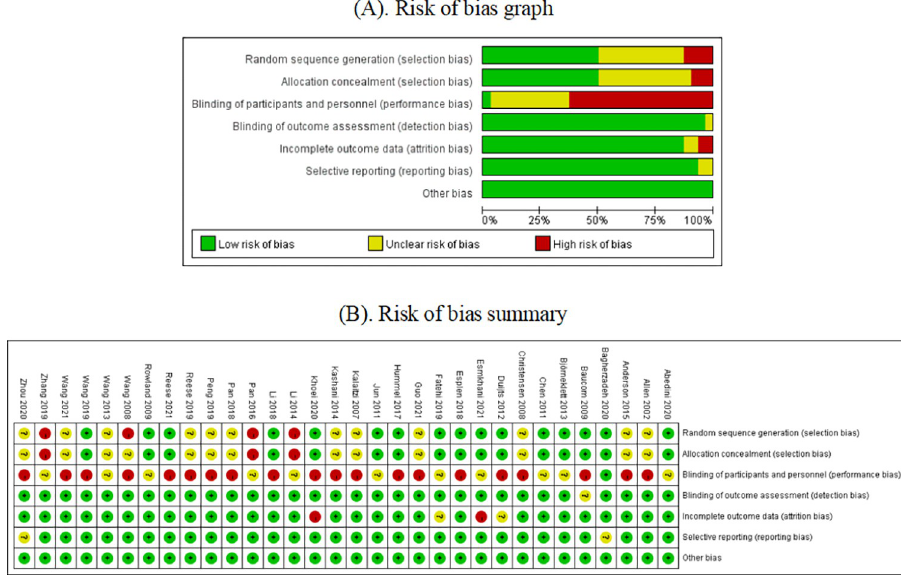
Fig 2. Quality assessment of included